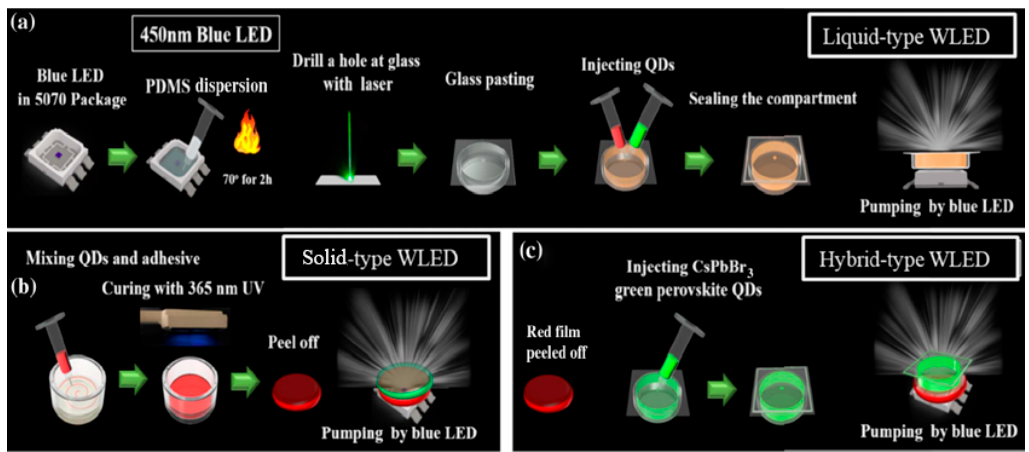
Figure 11. Process flow of perovskite quantum dots (PQDs)-based WLEDs: ( a ) liquid, ( b ) solid, and ( c ) hybrid types [74]. Figure reproduced with permission from Optical Society of